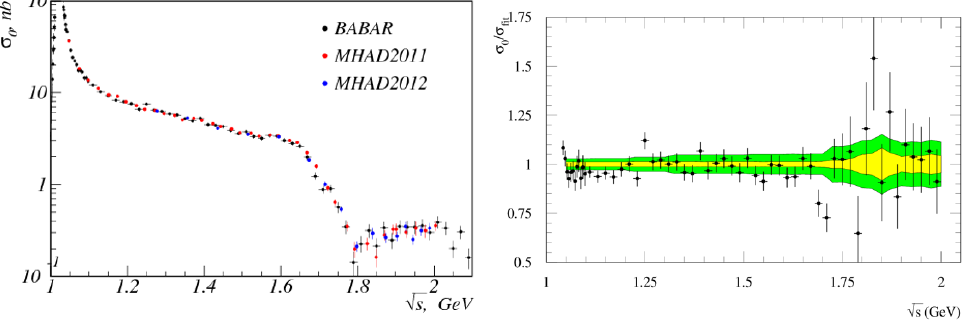
Figure 2. Left panel : The e + e − → K + K − cross section measured by SND at VEPP2000 and in the BABAR experiment [12]. Right panel : The relative di ff erence between the e + e − → K + K − cross sections measured by BABAR and the fit to the SND data. The SND and BABAR systematic uncertainties are shown by the yellow and green bands,